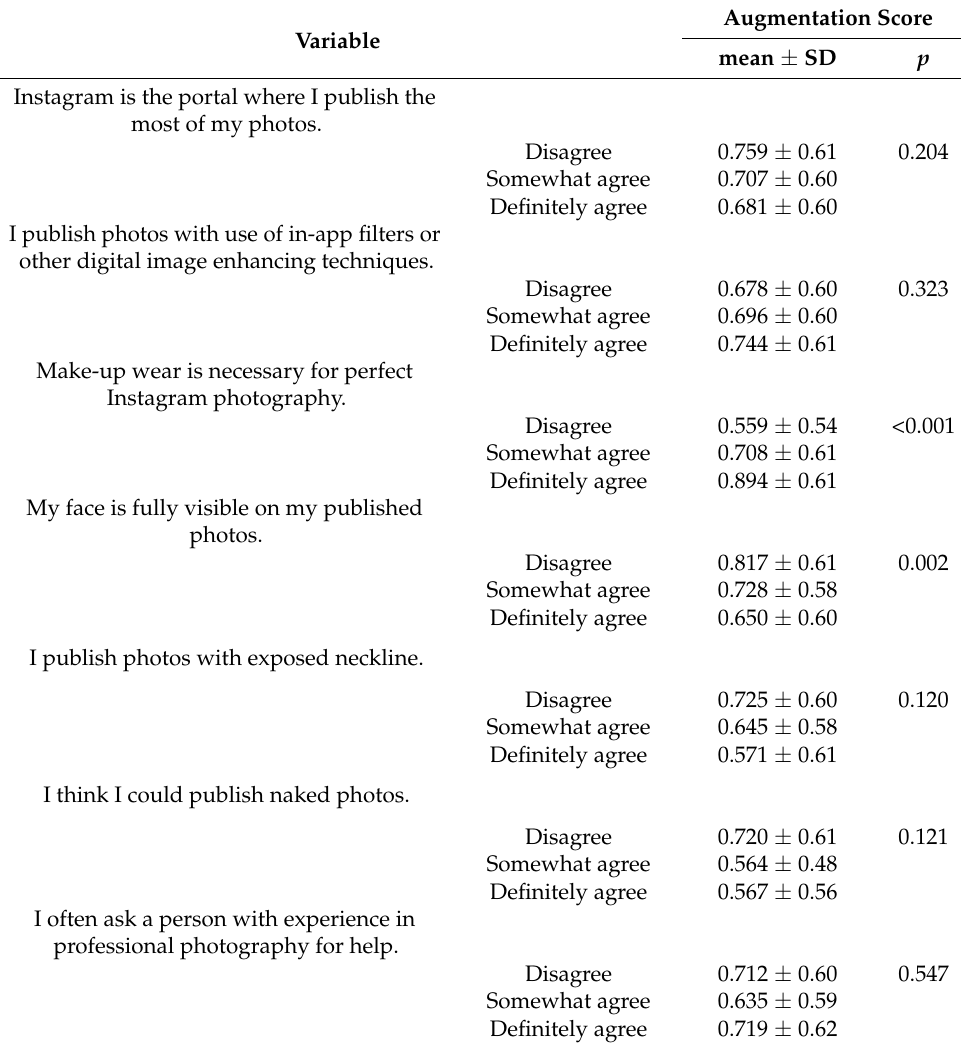
Table 7. Univariate analysis of associations between augmentation scores and respondent’s Instagram habits and preferences ( n =